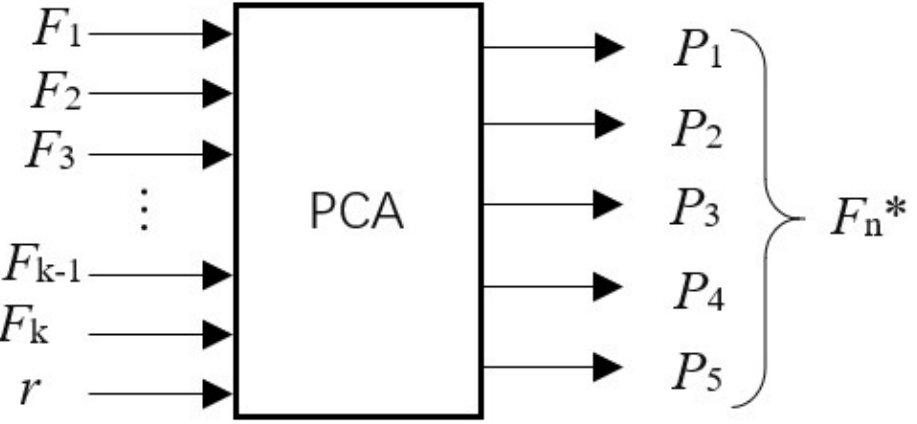
Figure 5. PCA method to reduce the information.